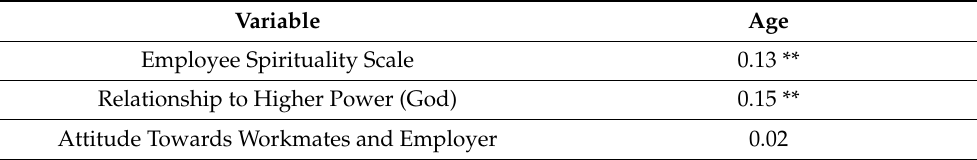
Table 4. Correlation between employee spirituality scale and dimensions and age ( N =